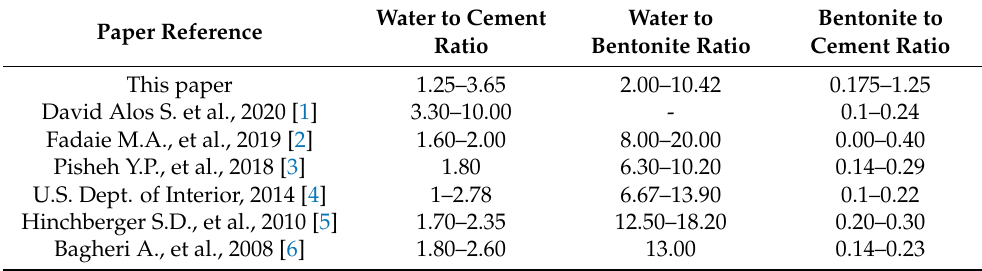
Table 1. Reference values from previous contributions.